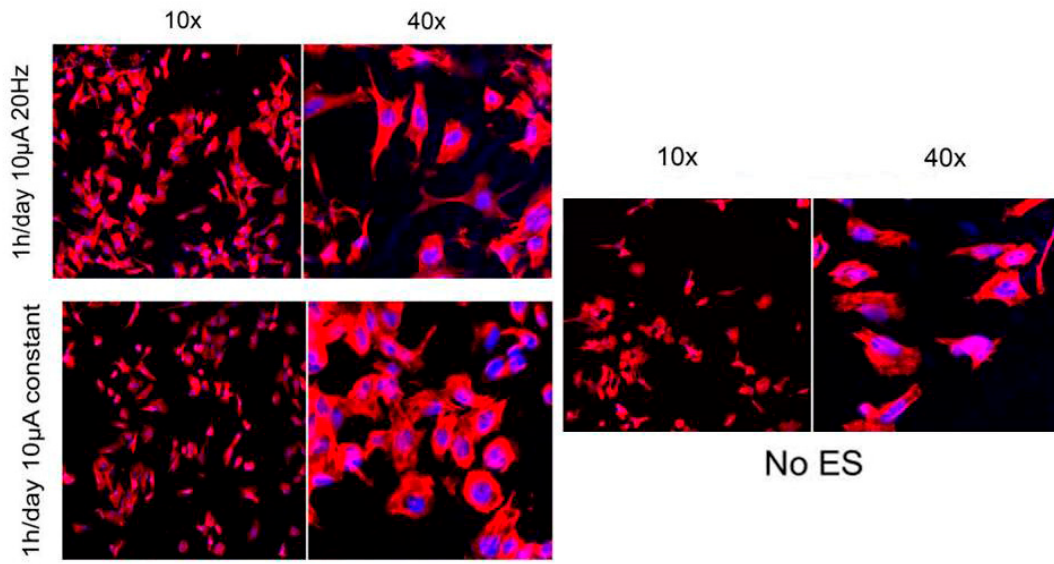
Table 1. Conductive materials used in tissue